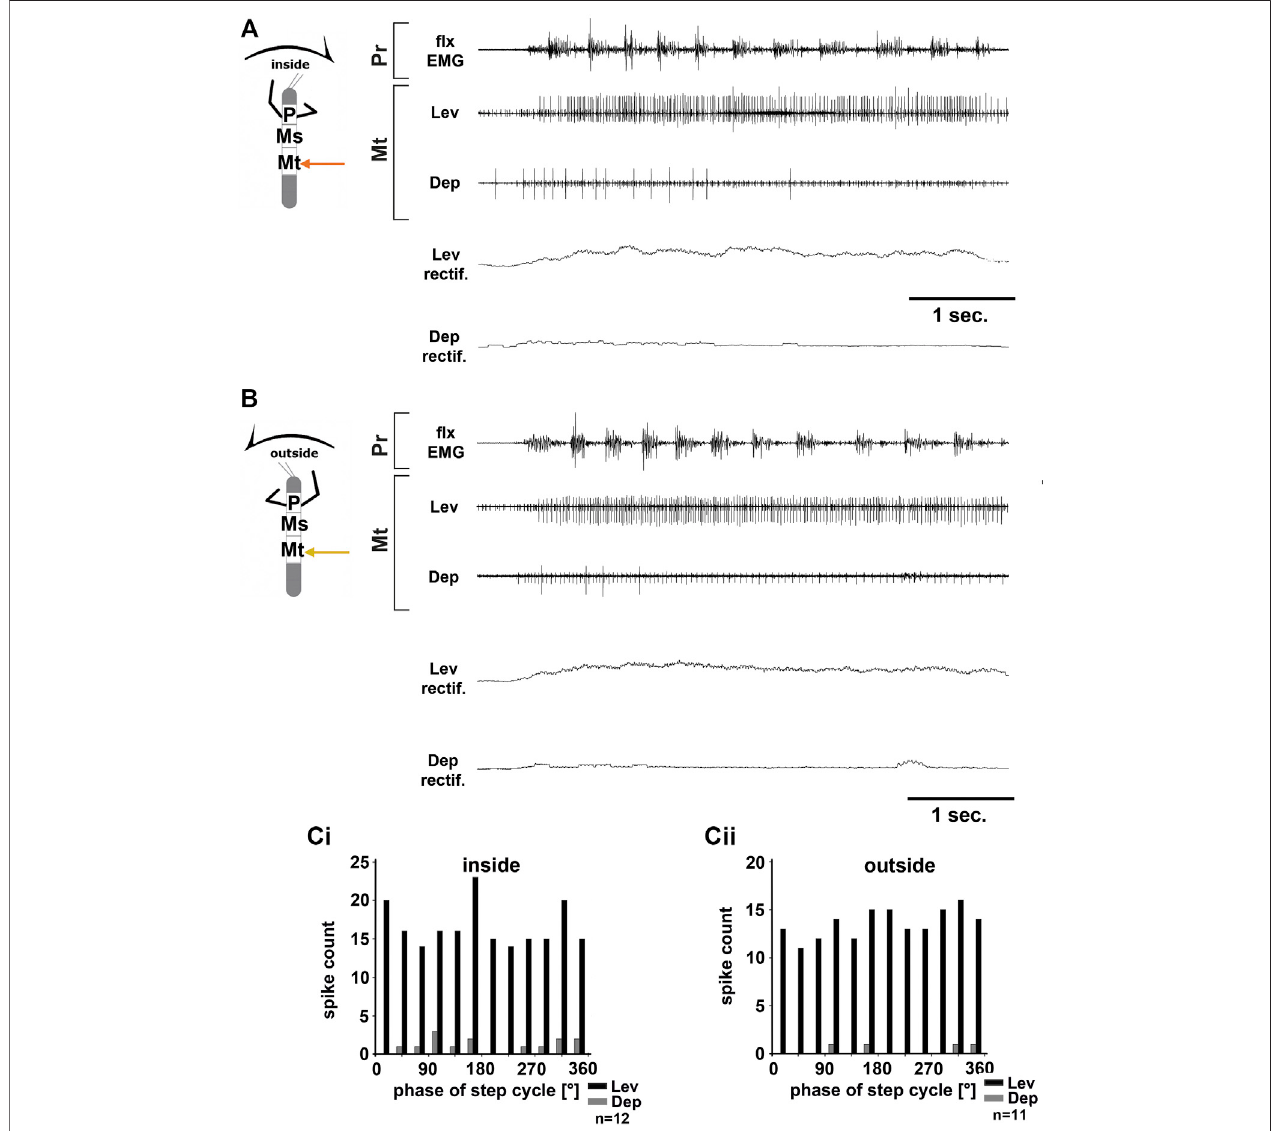
FIGURE 4 | Motor output of the metathoracic levator and depressor trochanteris MN pools in the deafferented ganglion during front leg (FL) inside (A,Ci) and outside (B,Cii) stepping from the sameanimal. (A) FL fl exor EMG recording (top),together with extracellular recordings of the ipsilateral levator (C1 nerve, second trace) and depressor (C2 nerve, third trace) nerve during an inside stepping sequence, and the respective recti fi ed activities (fourth and fi fth trace); (B) FL fl exor EMG (top), together with extracellular recordings of the ipsilateral levator (second trace) and depressor (third trace) nerve during an outside stepping sequence, and the respective recti fi ed activities (fourth and fi fth trace); (Ci) Phase histogram of levator and depressor nerve activity from the experiment in (A) with respect to the FL step cycle during inside stepping; (Cii) Phase histogram of levator and depressor nerve activity from the experiment in (B) with respect to the ipsilateral FL step cycle during outside stepping. n = number of analyzed steps. Pr, Mt: Pro- and Metathoracic location of the recording, respectively; Lev, Dep: levator trochanteris and depressor trochanteris motor neuron activity from nerves C1 and C2, respectively. The sketch indicates a stick insect with front legs in a fl exed (inside) or stretched (outside) position, and the arrow above indicating the turning direction, the arrow on the side the recorded thoracic